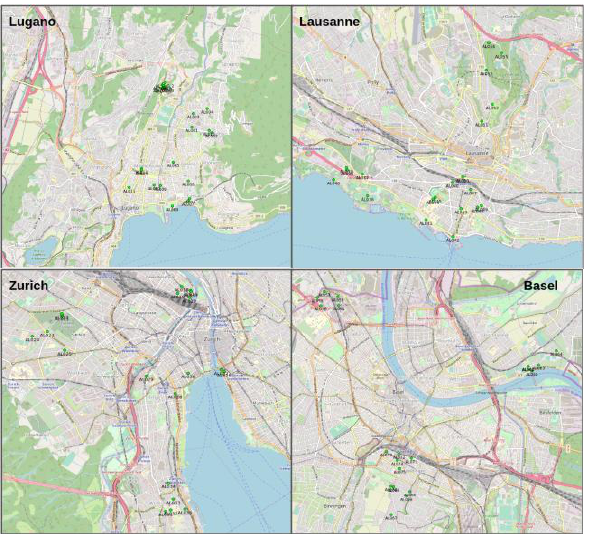
Figure 4. Maps of the 75 sensors deployed in four Swiss